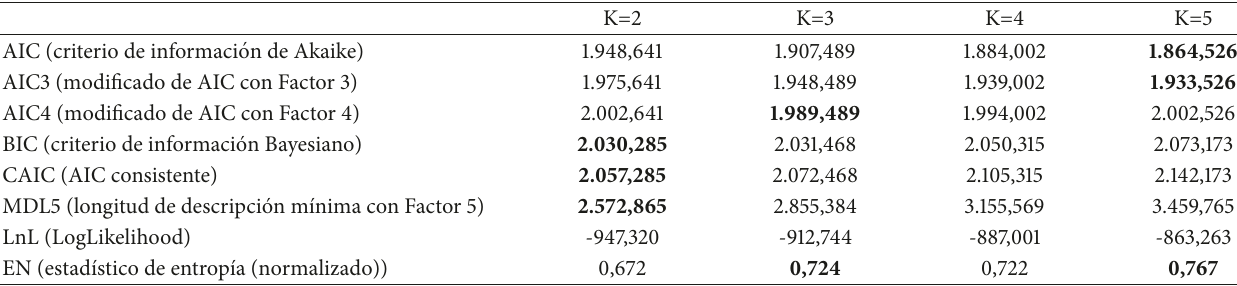
Table 6: Indices FIT. Criteria for model